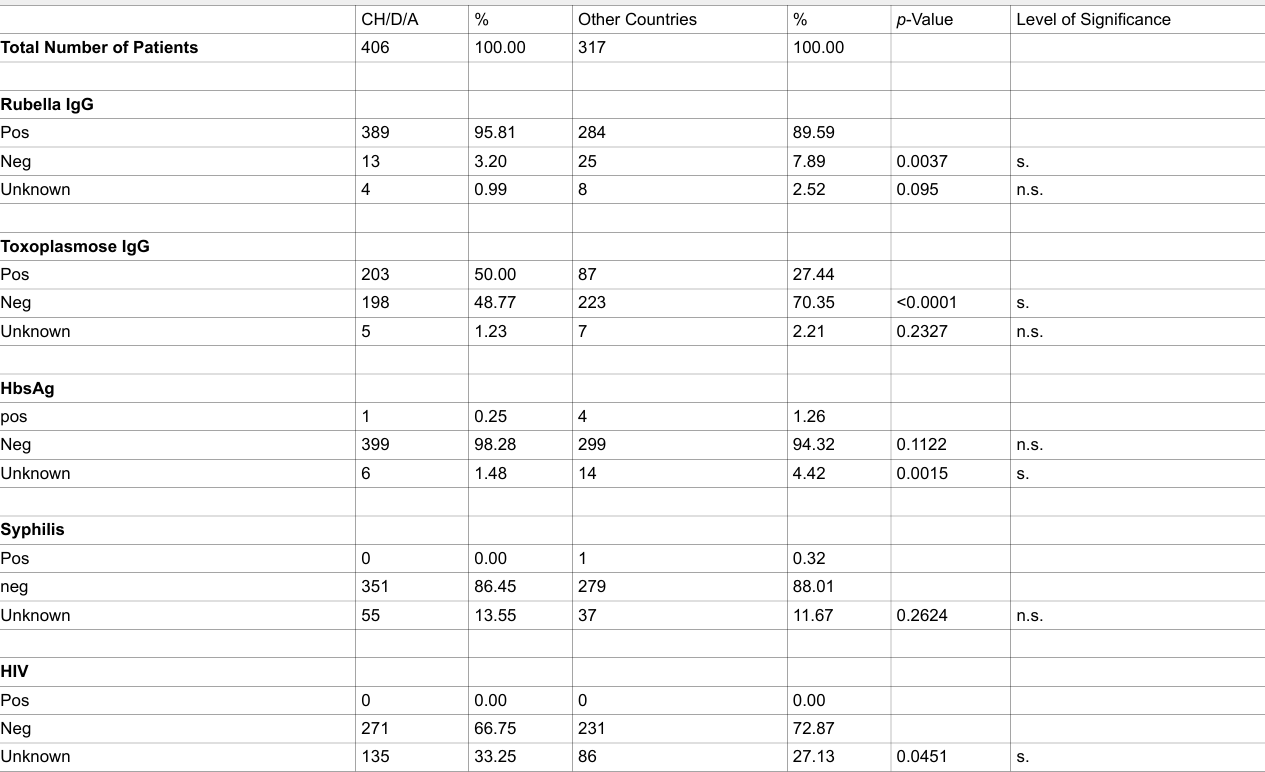
Table 2: Individual results of the serologies divided for group 1 (CH/D/A) and 2 (other countries). CH/D/A % Other